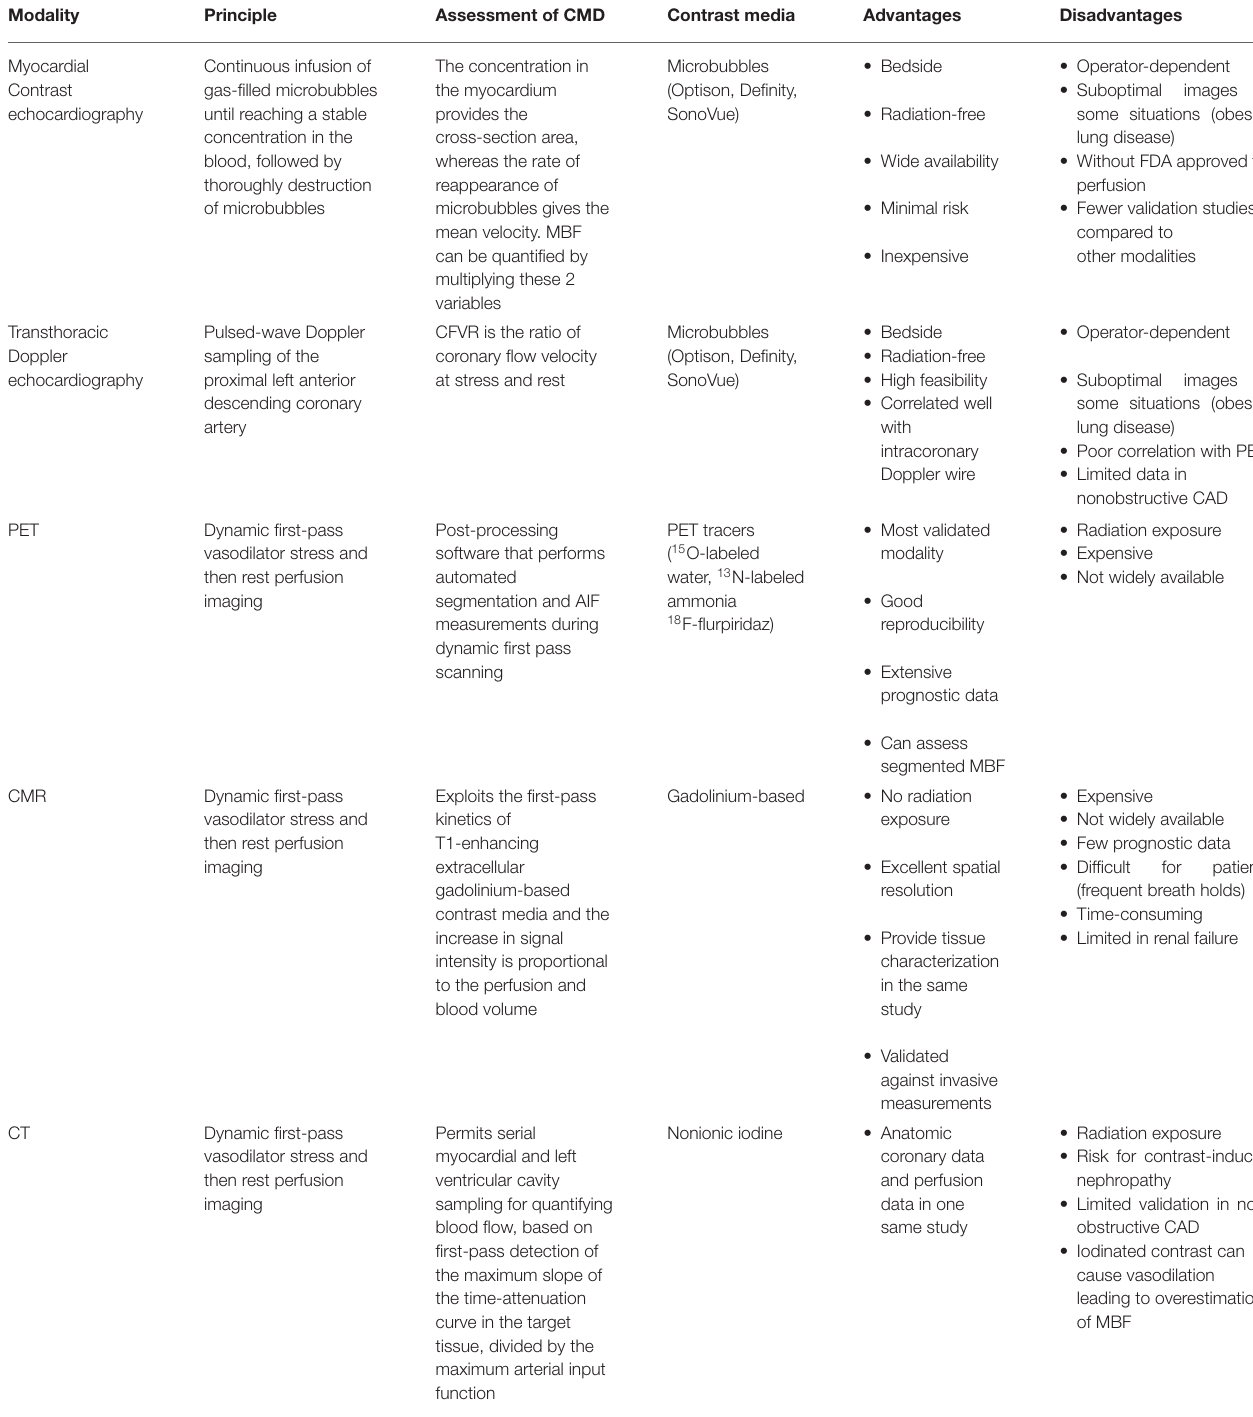
TABLE 2 | Various invasive and non-invasive imaging modality and their advantages and